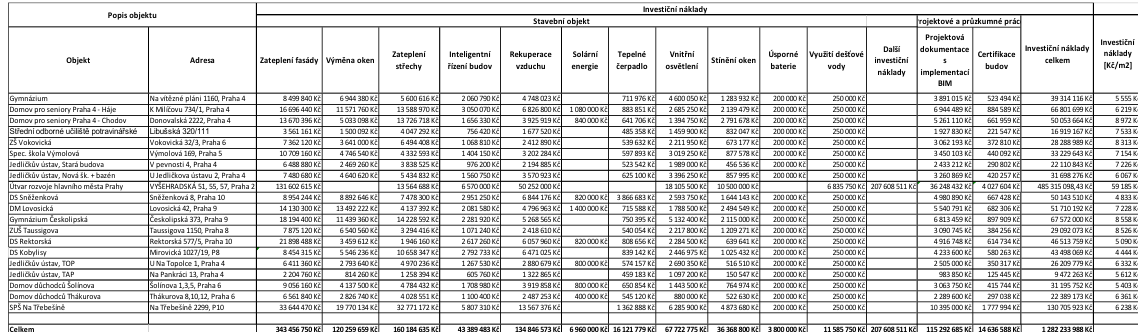
Pro všechny objekty vybrané do pilotního projektu byly určeny předpokládané náklady na realizaci úsporných opatření a implementaci systémů inteligentních budov. Výše uvedená tabulka shrnuje jednotlivé investiční náklady pro jednotlivé budovy. Celkové předpokládané investiční náklady dosahují výše 1,28 mld. Kč. Při této investici dojde ke snížení spotřeby primární energie o více než 50 % oproti stávajícímu stavu. Nákladově významně vyčnívá soubor budov Útvaru rozvoje hlavního města Prahy. Tyto značně vysoké investiční náklady jsou způsobeny kompletní rekonstrukcí budovy, včetně vnitřních instalací a technologií. Bude nezbytné zasáhnout do nosných konstrukcí a měnit dispozice a vnitřní uspořádání. Je předpoklad, že budova po rekonstrukci bude splňovat požadavky lokalizované komplexní